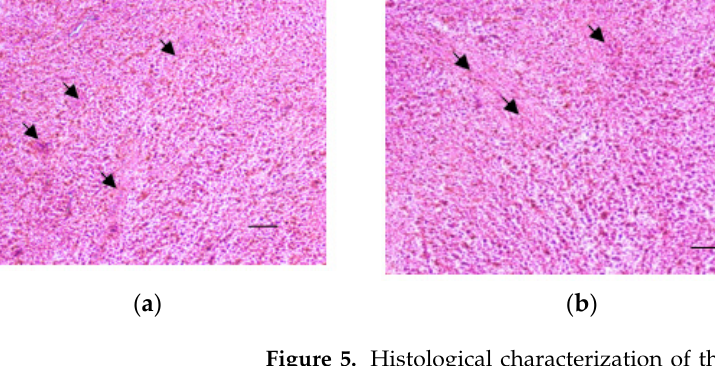
Figure 5. Histological characterization of the organotypic model. Hematoxyline-eosine stained cryosections of UL frag- ments after 7 ( a ), 14 ( b ), and 21 ( c ) days of culture (magnification × 100; scale bar is 200 µm). Arrows mark extracellular matrix.